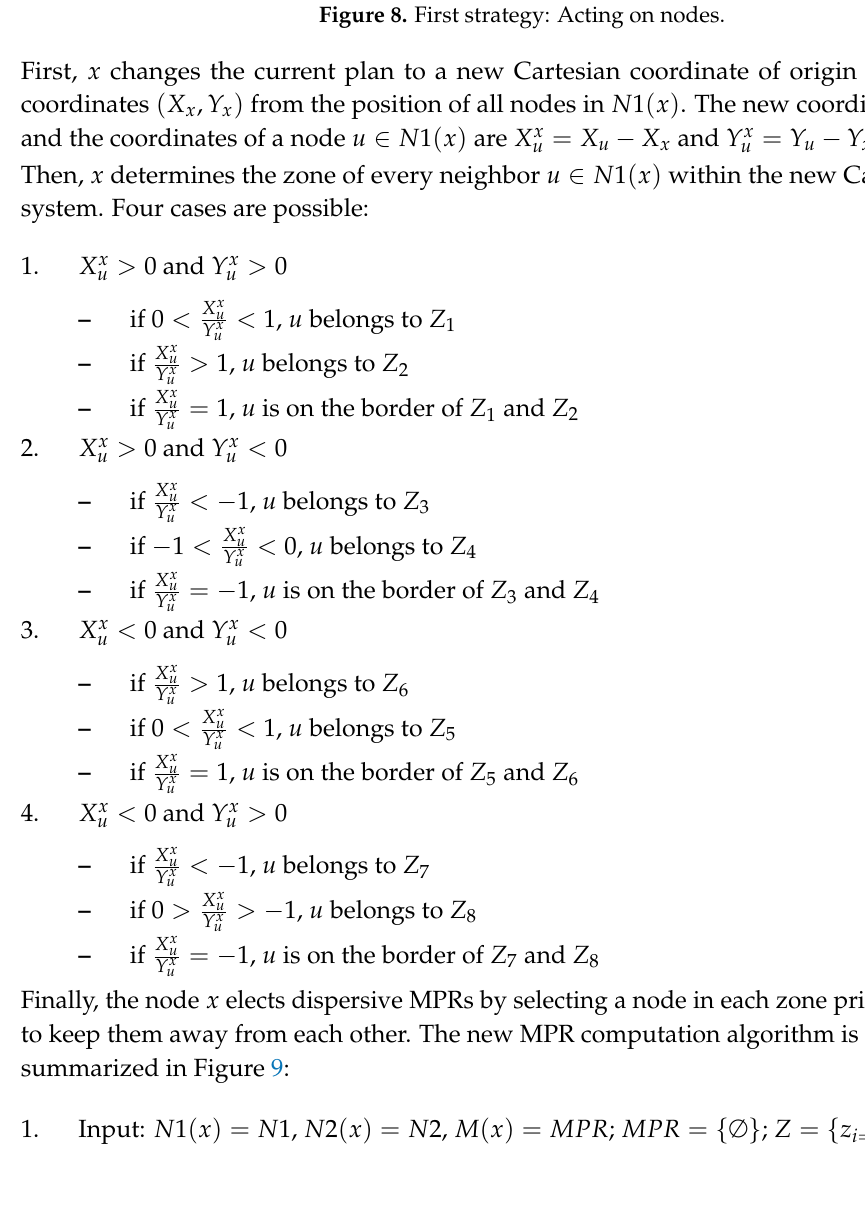
Figure 8. First strategy: Acting on